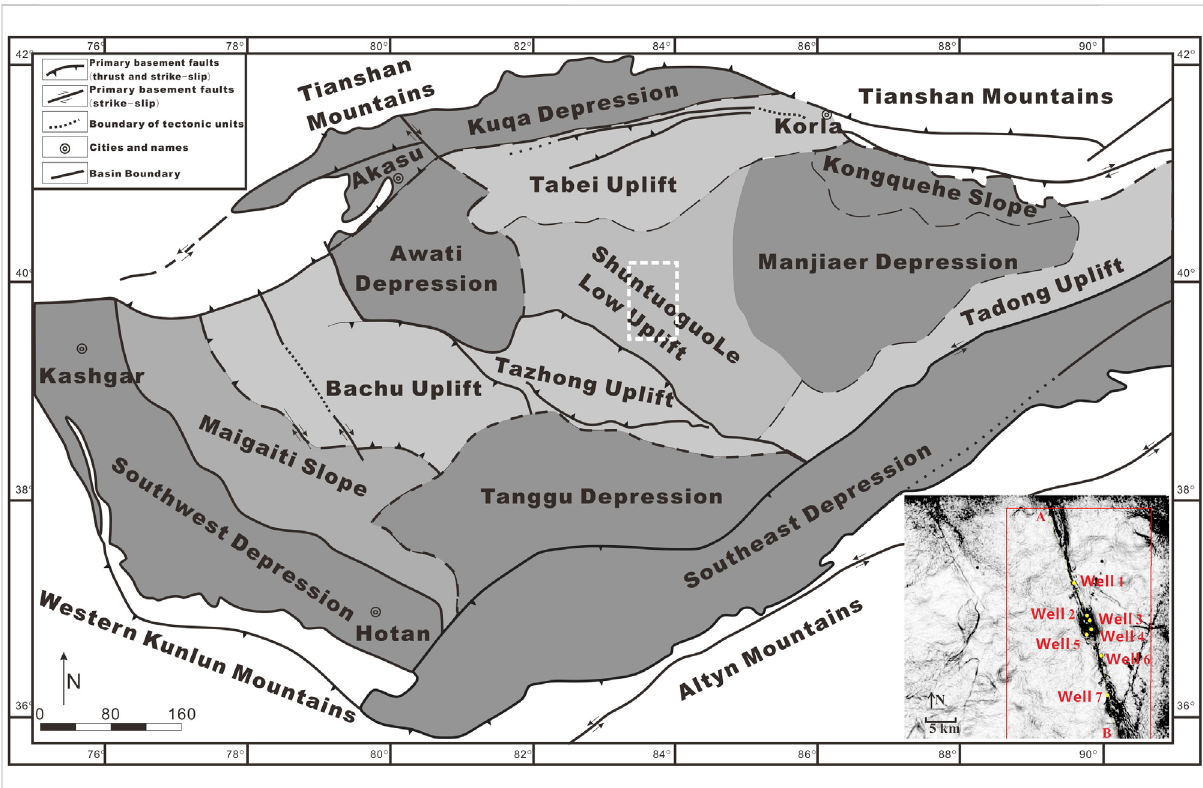
FIGURE 1 Map showing the location of the Shunbei oil fi eld and main tectonic units in the Tarim Basin (modi fi ed by Deng et al., 2019). The inset (lower right) corresponds to the location of the white dotted box, showing the distribution of strike – slip fault zones and wells in the study